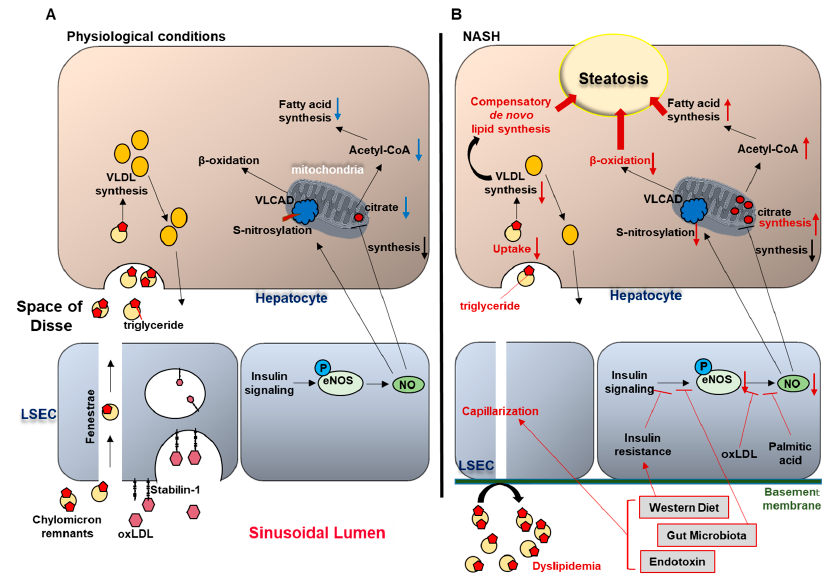
Figure 2. Liver sinusoidal endothelial cells (LSEC) and hepatic steatosis ( A ) under physiological conditions and ( B ) in nonalcoholic steatohepatitis